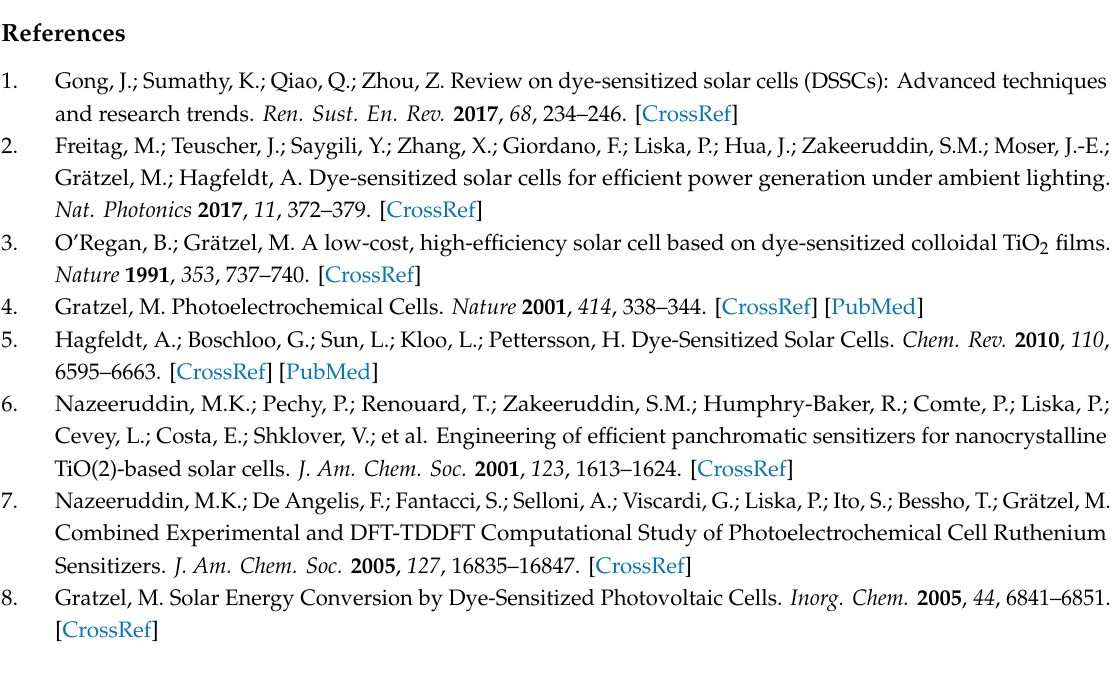
Figure S1: Selected area electron di ff raction (SAED) patterns for the mesoporous TiO 2 film (a), and the bu ff er layers: TO10 (b), TO50 (c), TAR10 (d), and TAR50